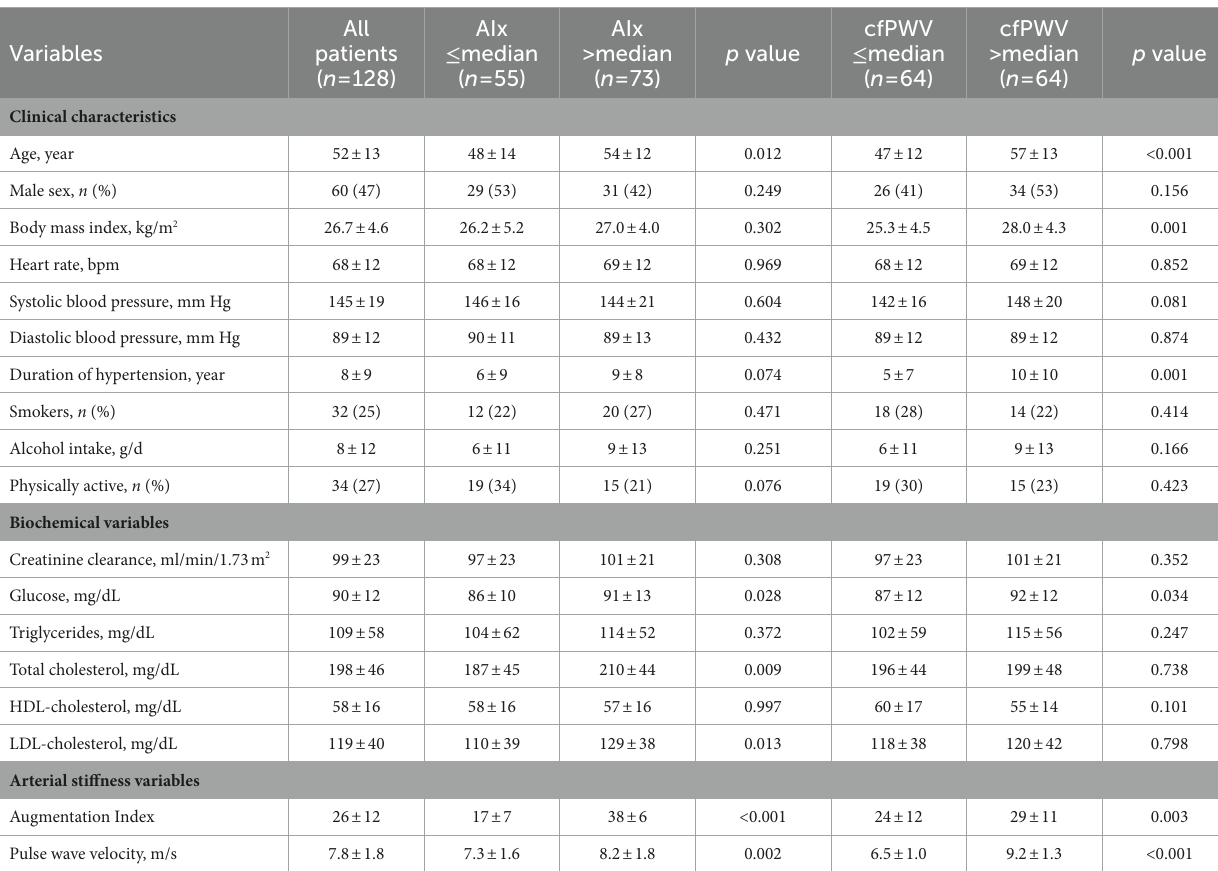
TABLE 1 Clinical characteristics and biochemical variables of hypertensive patients who were grouped according to the median value of the Augmentation Index (AIx) and carotid-femoral pulse wave velocity (cfPWV).